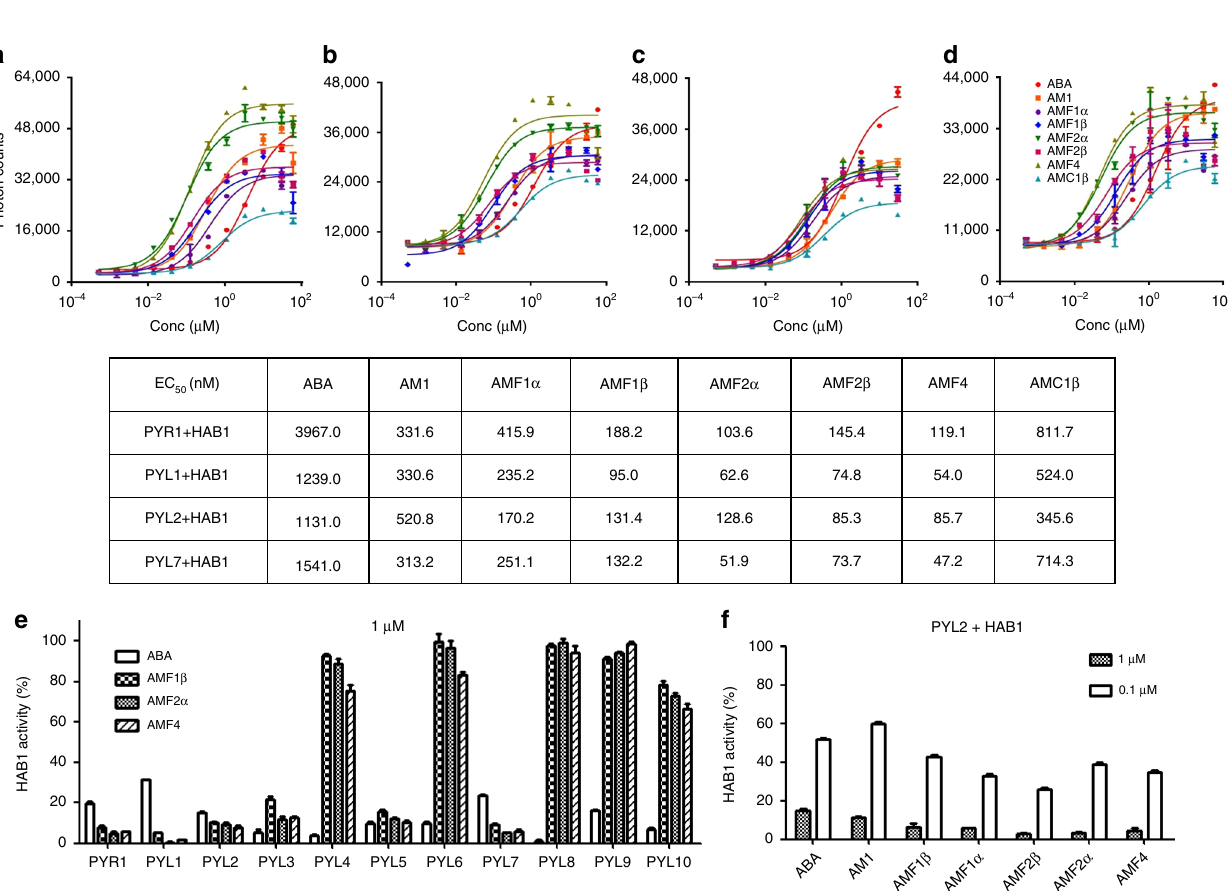
Fig. 2 AMFs are potent PYL receptor agonists. a – d Agonist dose – response curves for AMFs and AMC1 β . Dose-dependent interactions between HAB1 and PYR1 ( a ), PYL1 ( b ), PYL2 ( c ), or PYL7 ( d ) in the presence of all fi ve AMFs, AMC1 β , AM1 and (+)-ABA are determined in AlphaScreen assays. EC 50 values for the interactions are listed below the curves ( n = 3, error bars = SD). e Inhibition of HAB1 activity induced by AMFs and mediated by the 11 PYLs in phosphatase activity assays. The working concentration is 1 μ M for AMF1 β , AMF2 α , and (+)-ABA. Values are means ± SD ( n = 3). f Dose-dependent inhibition of HAB1 activity resulting from the binding of AMFs to the PYL2 – HAB1 complex. The working concentrations are 1 and 0.1 μ M for all fi ve AMFs and (+)-ABA. Values are means ± SD ( n =